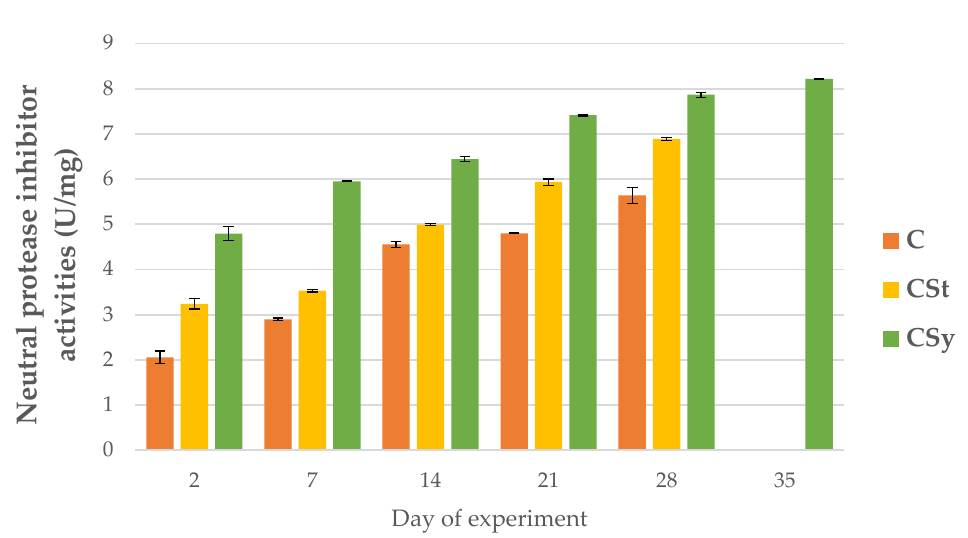
Figure 6. Neutral protease inhibitor activities in the 2, 7, 14, 21, 28, 35-day-old honey bees’ hemolymph after two methods of supplementation with hemp extract: C-control (pure sugar syrup), CSy-hemp extract in syrup, CSt-hemp extract on strips. (Two-Way ANOVA: supplementation method: F (2, 156) = 66.832, p = 0.0000, se ± 0.185759–0.167870; days of supplementation: F (4, 143) = 8999.5, p = 0.0000, se ± 0.014626–0.025333; supplementation method × days of supplementation F (8, 143) = 156.29, p = 0.0000, se ± 0.025333.